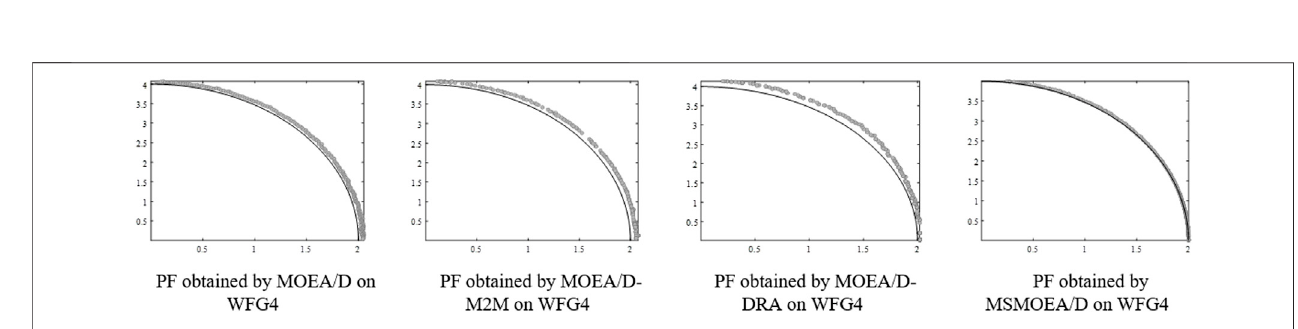
FIGURE 11 | PF obtained by MSMOEA/D and MOEAs on two-objective WFG4.